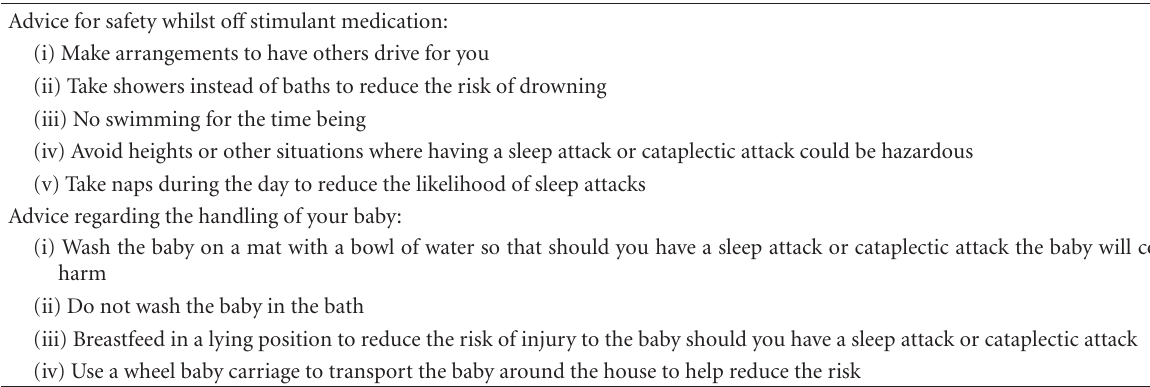
Table 1: Instructions for pregnant narcoleptic women